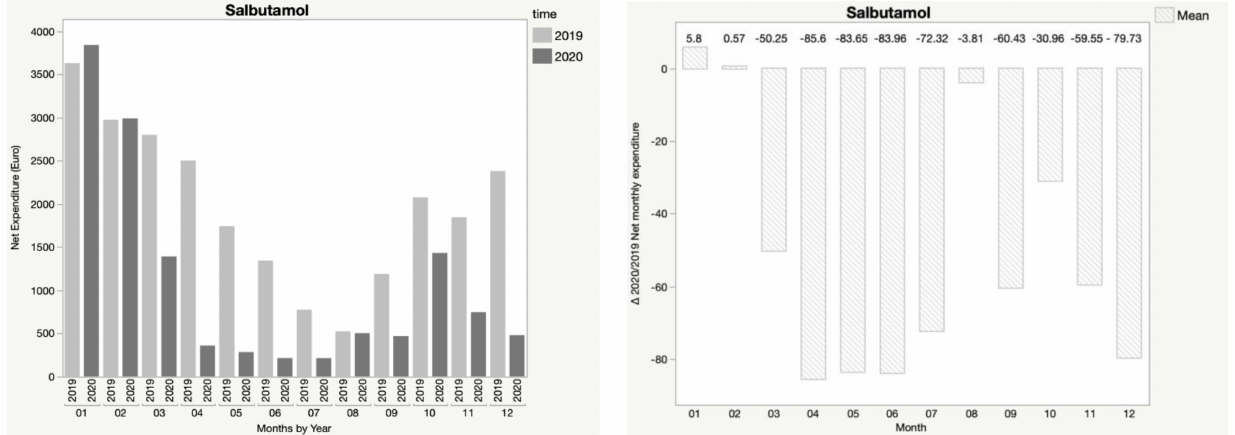
Figure 1. Trend in net expenditure (EUR) and delta 2020/2019 of net monthly expenditure of salbutamol, from January